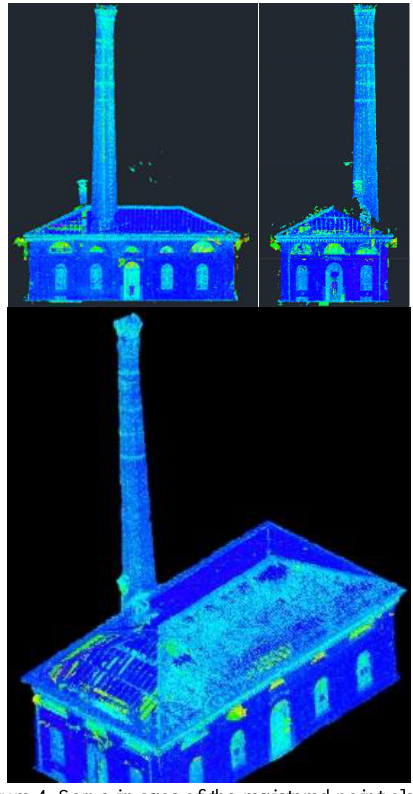
Figure 4. Some images of the registered point clouds in Autodesk